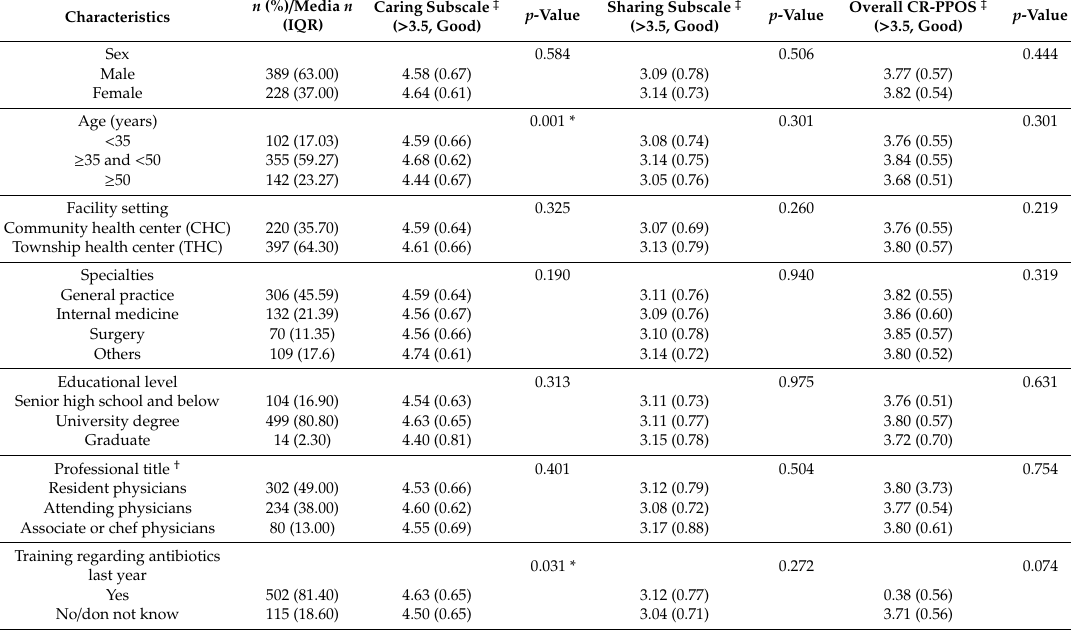
Physicians’ demographic characteristics and associations between Chinese-revised patient–practitioner orientation scale (CR-PPOS) scores and physicians’ characteristics ( n = 617).